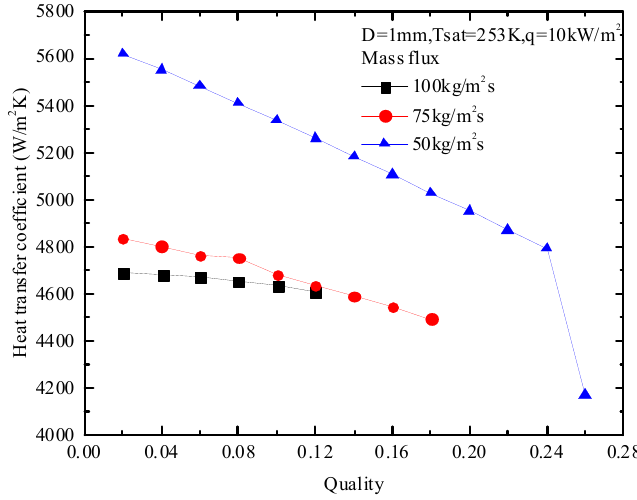
Figure 10. Effect of mass flux on heat transfer coefficient of R744.